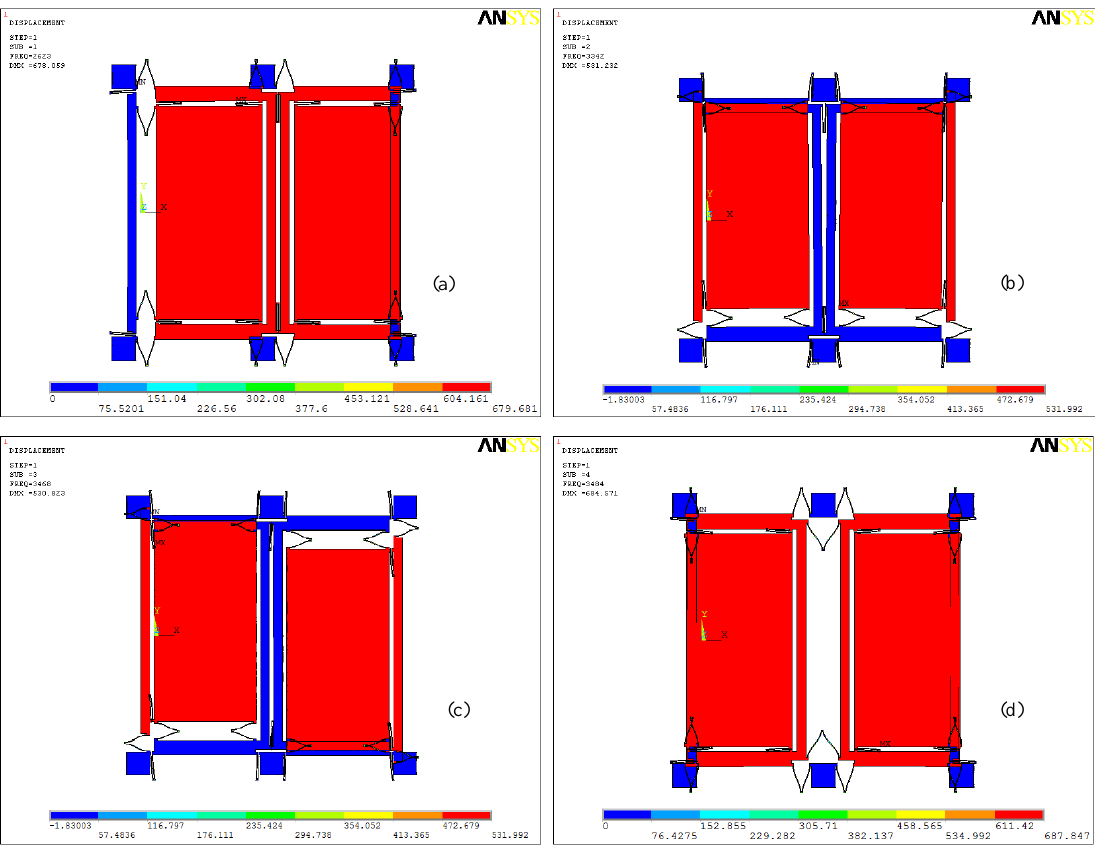
Figure 2. The first four orders modes of the dual-mass sensing mode coupling MEMS gyroscope structure: ( a ) Drive in-phase mode (first mode) with frequency ω x 1 ; ( b ) sensing in-phase mode (second mode) with frequency ω y 1 ; ( c ) sensing anti-phase mode (third mode) with frequency ω y 2 ; ( d ) Drive anti-phase mode (fourth mode) with frequency ω x 2 . Table 1. MEMS gyroscope mechanical parameters under different temperatures (tested values). Temperature ( ◦